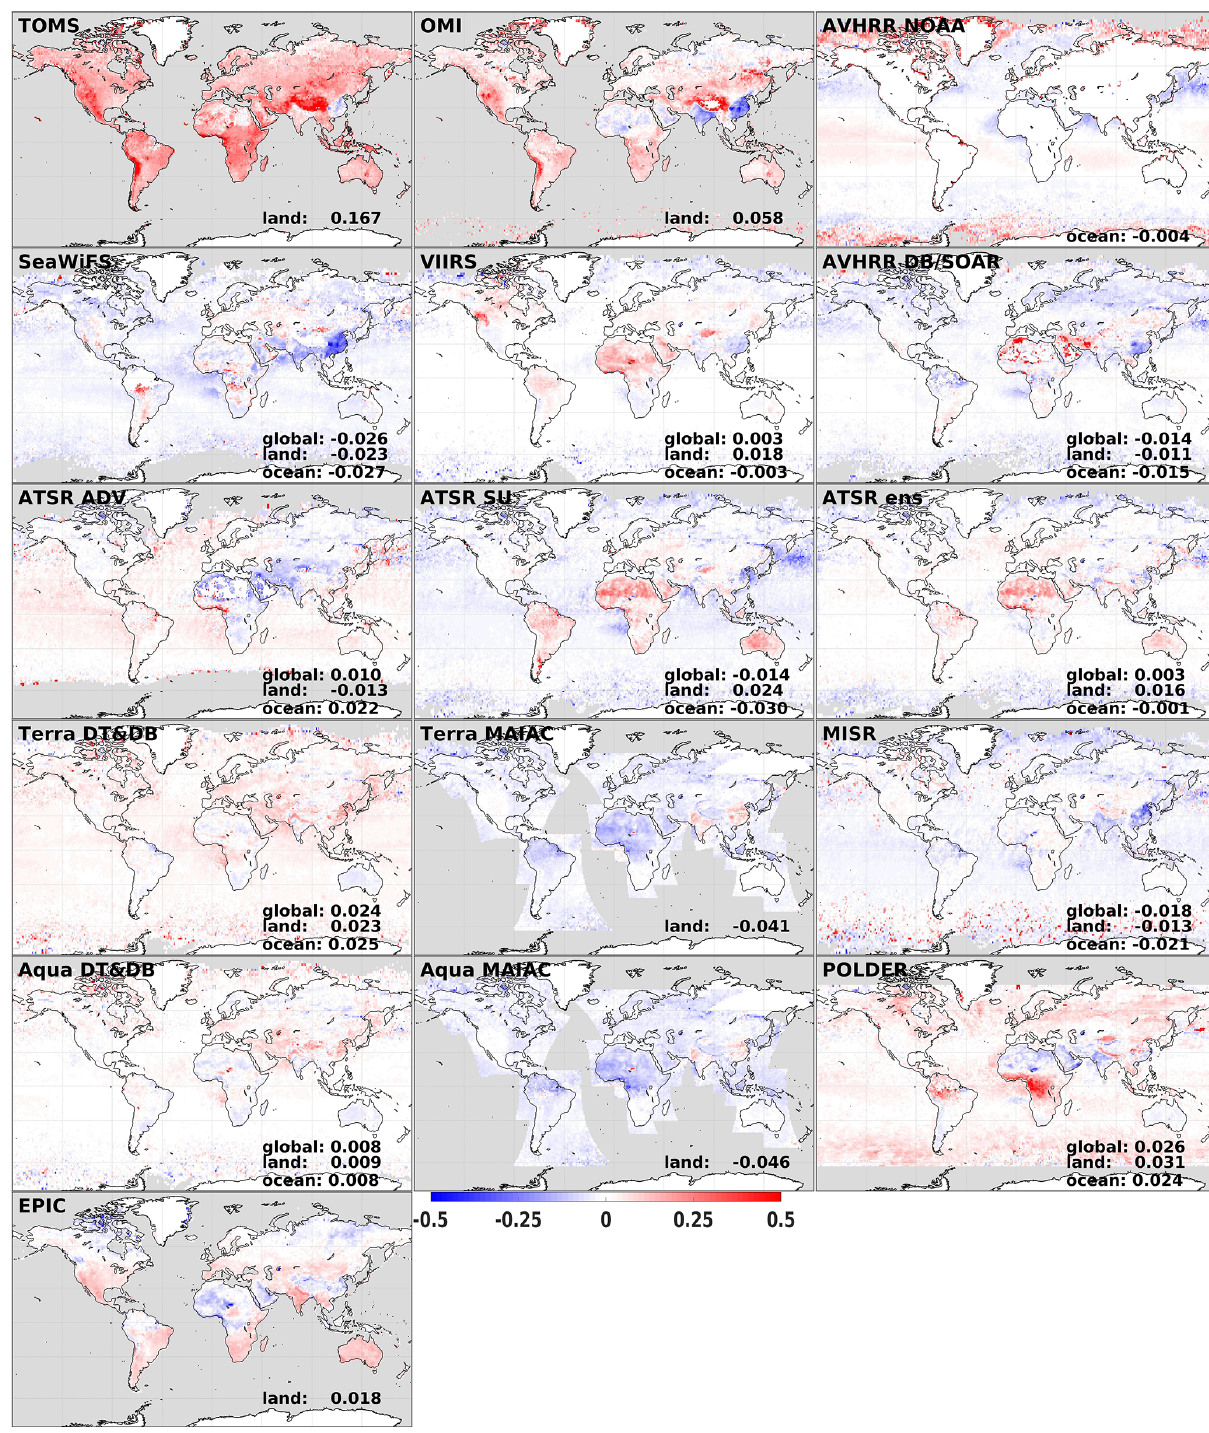
Figure 11. AOD deviation of the individual products relative to the merged AOD product for the year 2008. Global, land and ocean AOD mean differences are shown for each product, when